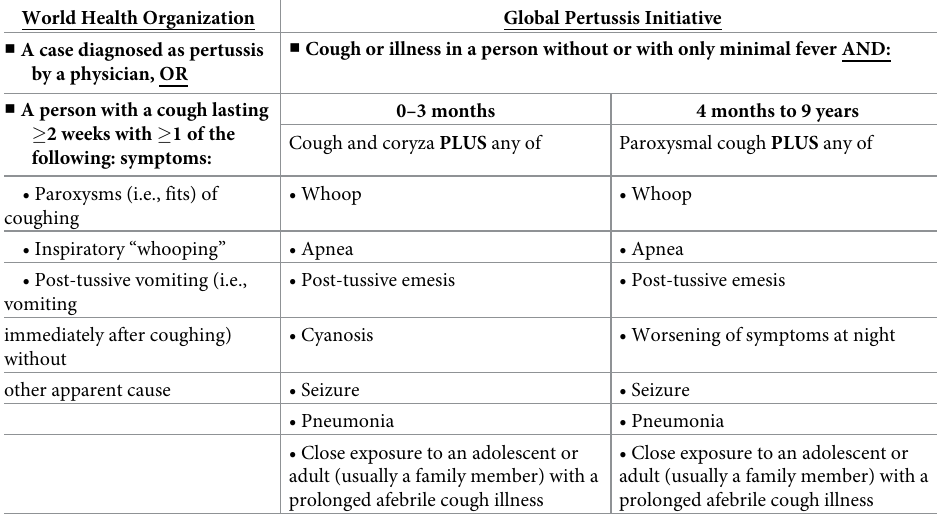
Table 1. Clinical features for diagnosis of pertussis